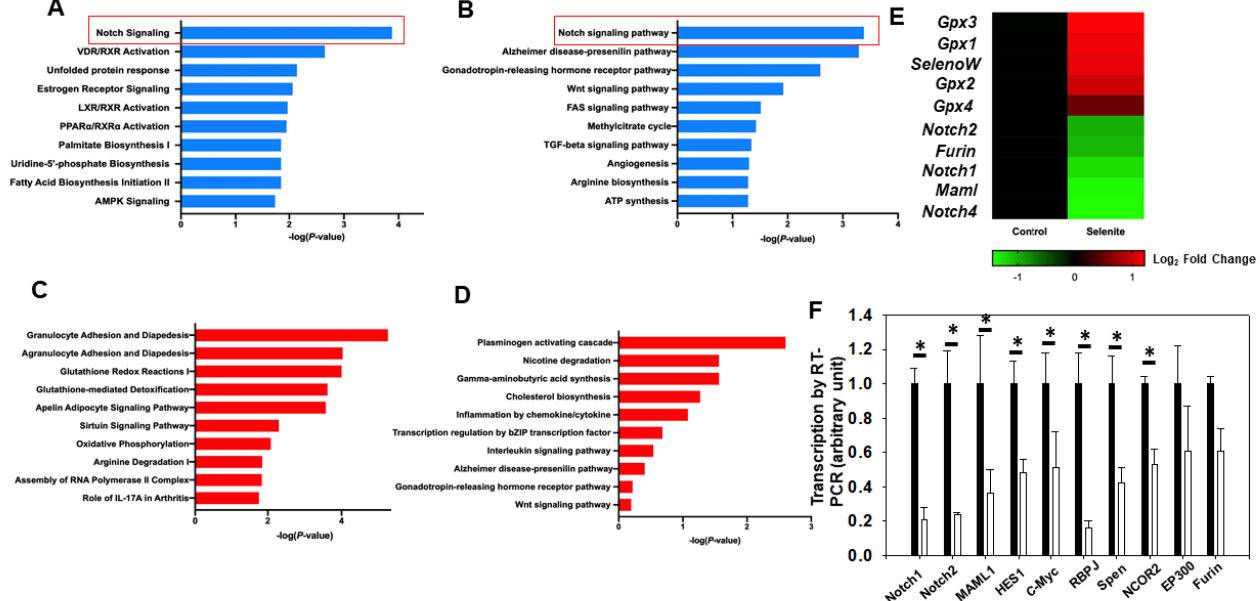
Figure 1. Transcriptomics analysis disclosed selenite downregulation of the Delta–Notch pathway in primary isolated hepatocytes. ( A ) Inuity Pathway Analysis showed pathways downregulated following selenite treatment. ( B ) GoPathway showed major pathways downregulated following selenite treatment. ( C ) Ingenuity pathway analysis showed pathways upregulated following selenite treatment. ( D ) GoPathway showed major pathways downregulated following selenite treatment. ( E ) Heat map plotting of differentially-expressed genes involving selenoproteins ( Gpx1 , Gpx3 , Gpx4 and Selenow ) and Notch signaling pathways ( Notch1 , Notch2 , Notch4 , Furin and Maml1 ). Data were normalized by a regularized log transformation. ( F ) Quantitative RT-PCR results showed the decrease in Notch1 signaling members, normalized by alpha tubulin ( n = 3). Ingenuity pathway analysis of the RNA-seq data was used to predict singling pathway activity (using a cut-off of p < 0.05 and the top 500 differentially expressed genes). * p < 0.05.